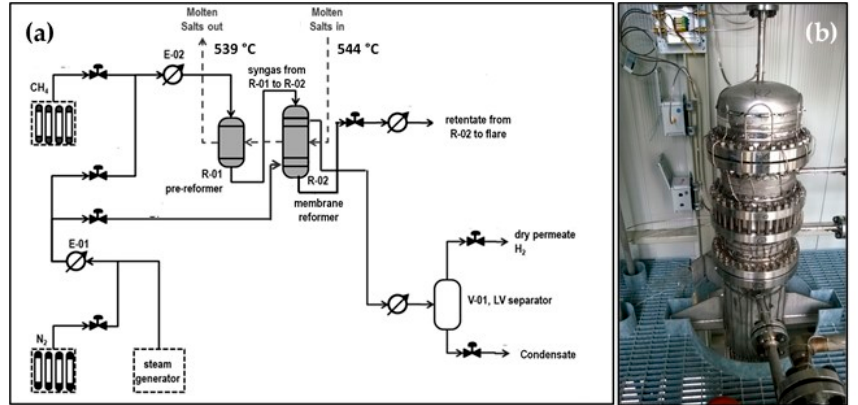
Figure 2. Pure hydrogen production membrane reactor in closed architecture ( a ) Process scheme; ( b ) Reactor assembly.